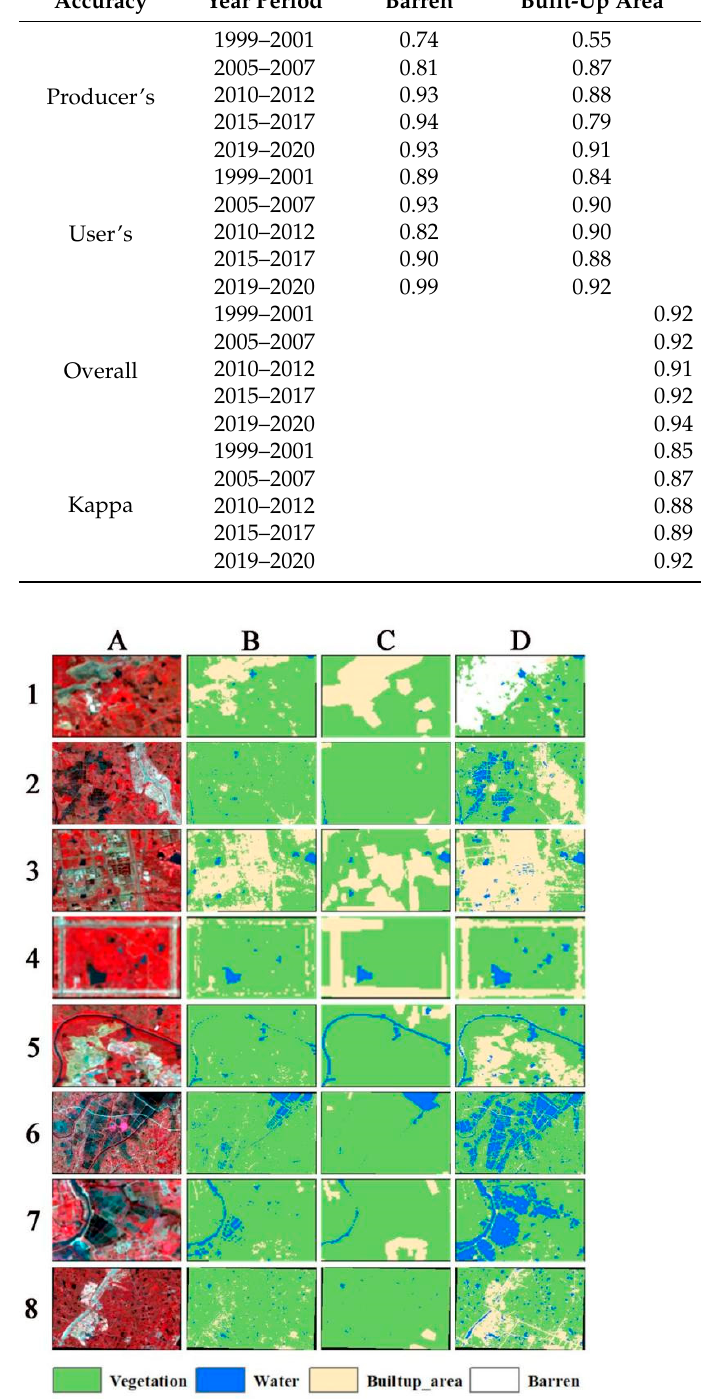
Figure 4. Comparison of different land cover products in 2020. ( A ) Landsat annual TOA false-color composition in 2020 (RGB: B5, B4, B3), ( B ) GLC_ FCS30, ( C ) GlobeLand30, and ( D ) this product. Comparison of different kinds of land cover types from 1 to